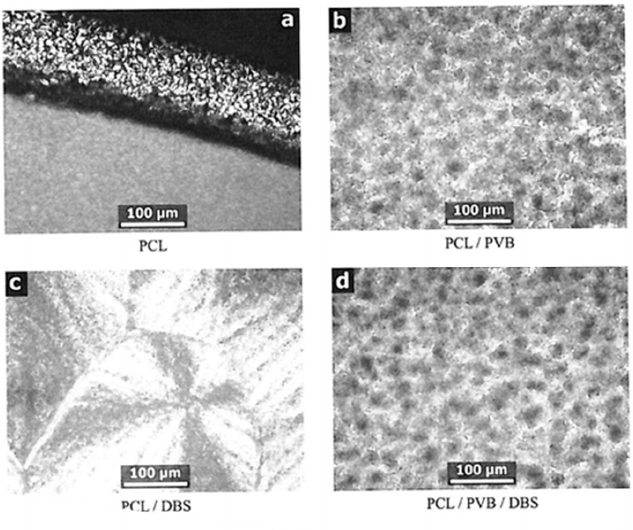
Figure 2. Optical Micrographs obtained in a polarised light microscope at room temperature of samples of ( a ) PCL; ( b ) PCL with 3%PVB; ( c ) PCL with DBS; and ( d ) PCL with 3% PVB and 3% DBS which were crystallised from the melt as described in the